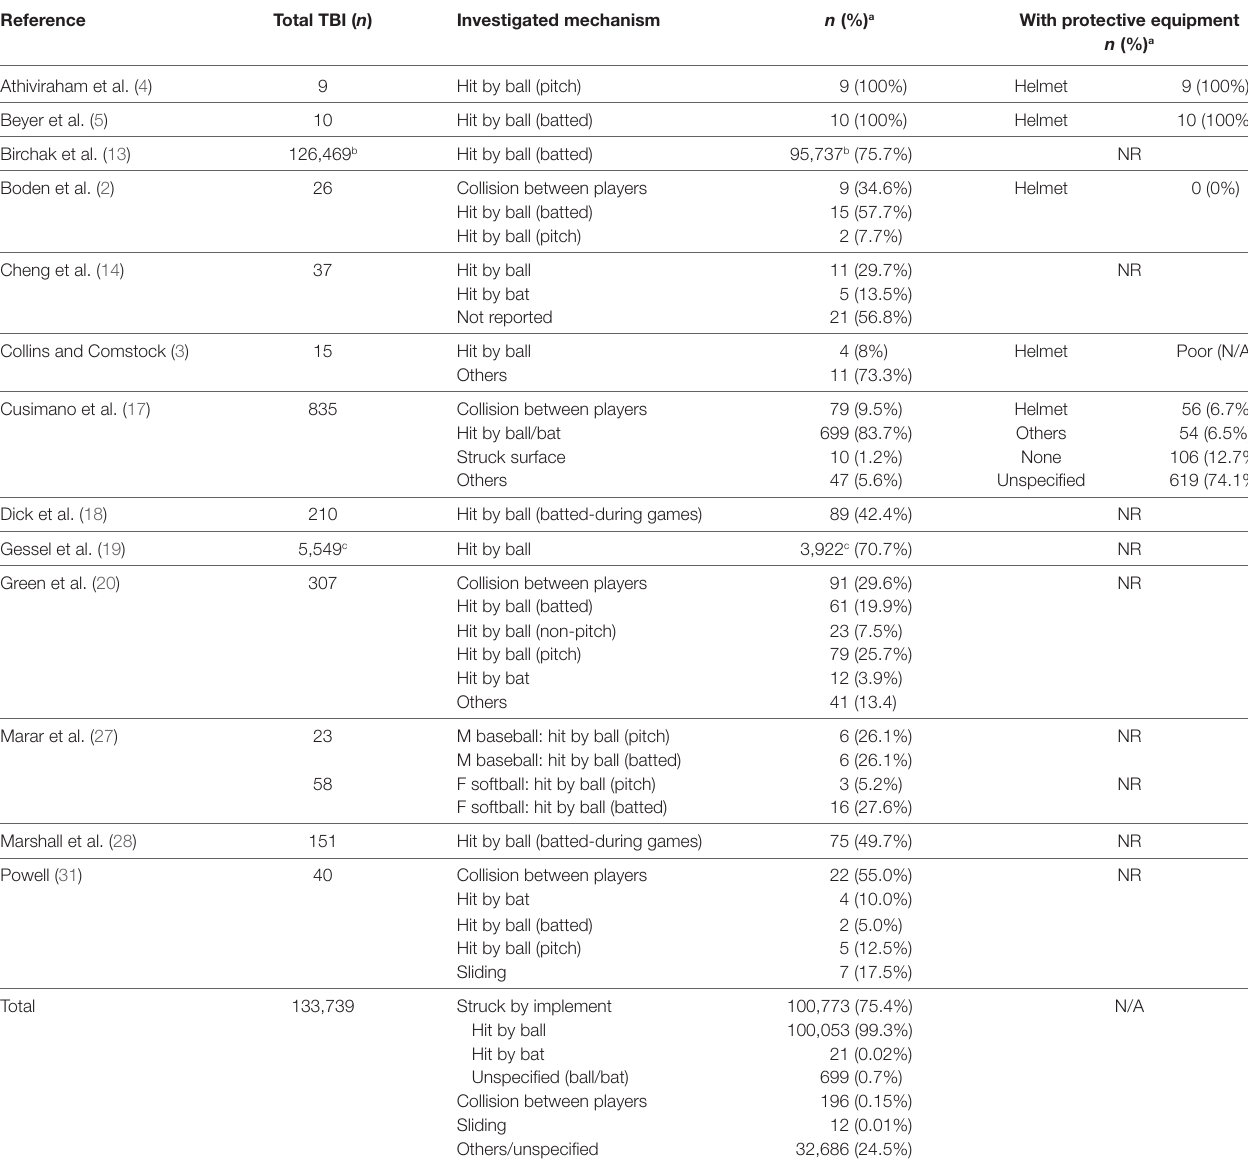
taBLe 5 | Mechanisms of TBI and protective equipment